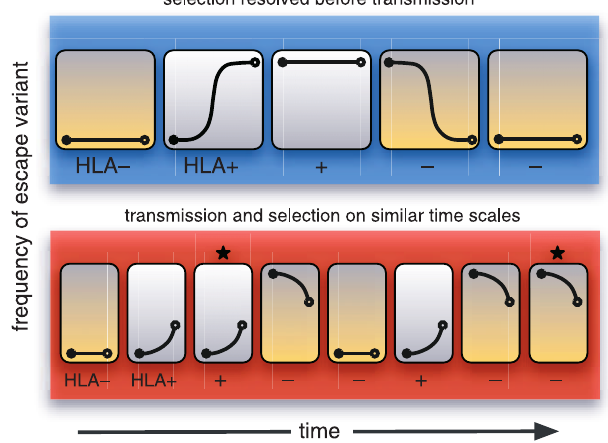
Figure 2. Effect of Transmission Rate on the Frequency of Mixtures This schematic depicts the transmission chain of a virus population, where each host is represented by an enclosed graph that represents the evolving frequency of a CTL escape variant over time. The hosts either possess an HLA allele which favors the escape variant (HLA þ , orange- shaded boxes) or the wild-type virus (HLA (cid:4) , white-shaded boxes). A severe transmission bottleneck causes the population in the next host to be initially fixed for either the wild-type or escape variant (filled circle). If selection for escape or reversion is sufficiently strong (upper schematic in blue), then the favored virus genotype will tend to become fixed within the host before transmission occurs (open circle). Under such conditions, transient polymorphisms will only occur whenever the virus is trans- mitted between hosts of opposite type. On the other hand, if transmission and selection occur on similar time scales (lower schematic in red), then the host type does not necessarily predict which virus genotype becomes transmitted, causing transient polymorphisms to become more abundant (starred